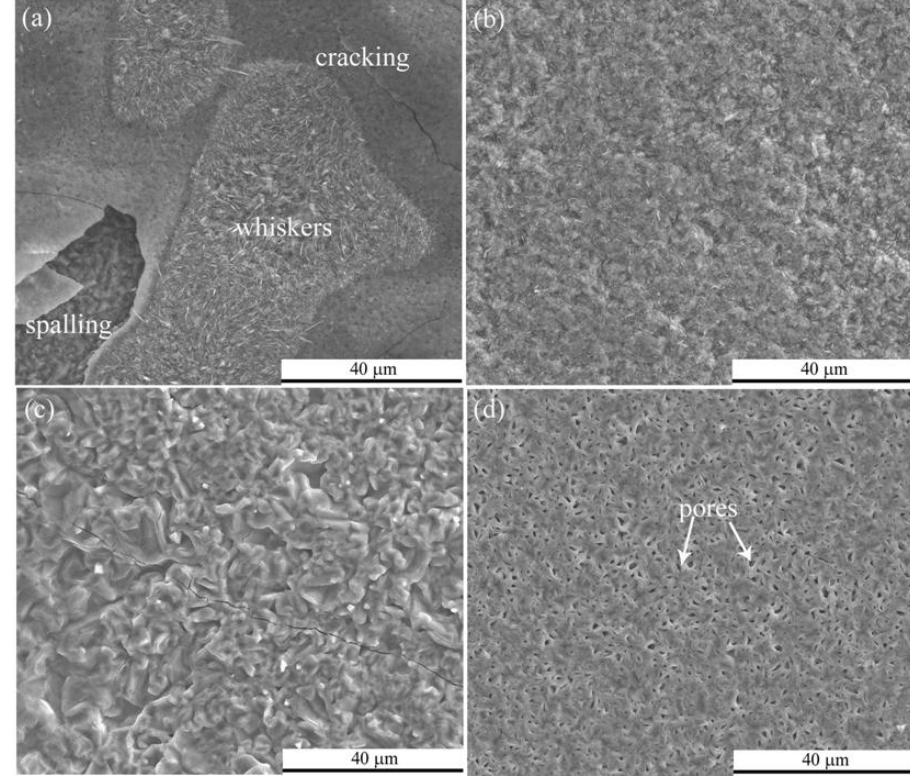
Figure 7. Surface morphologies of oxide scales formed on P92 after 24 h oxidation in pure steam at ( a ) 600 °C; ( b ) 700 °C; and ( c ) 800 °C; ( d ) showing the morphology of sub-scale after exfoliation of outer oxides at 600